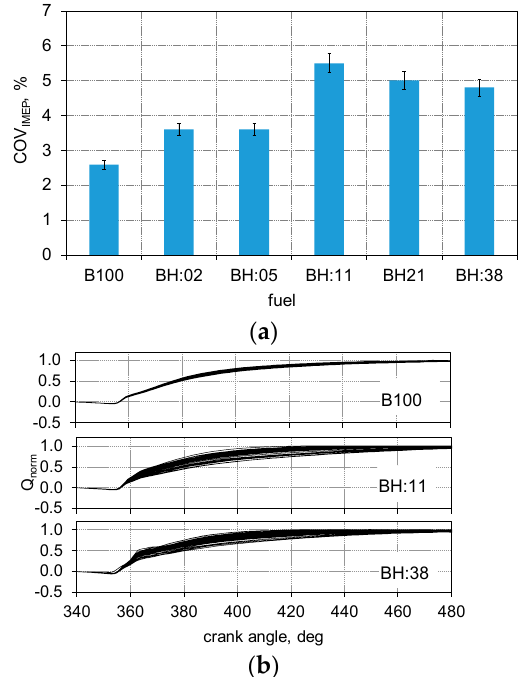
Figure 6. COV IMEP ( a ) and normalized heat released for B100, BH:11 and BH:38 ( b ).